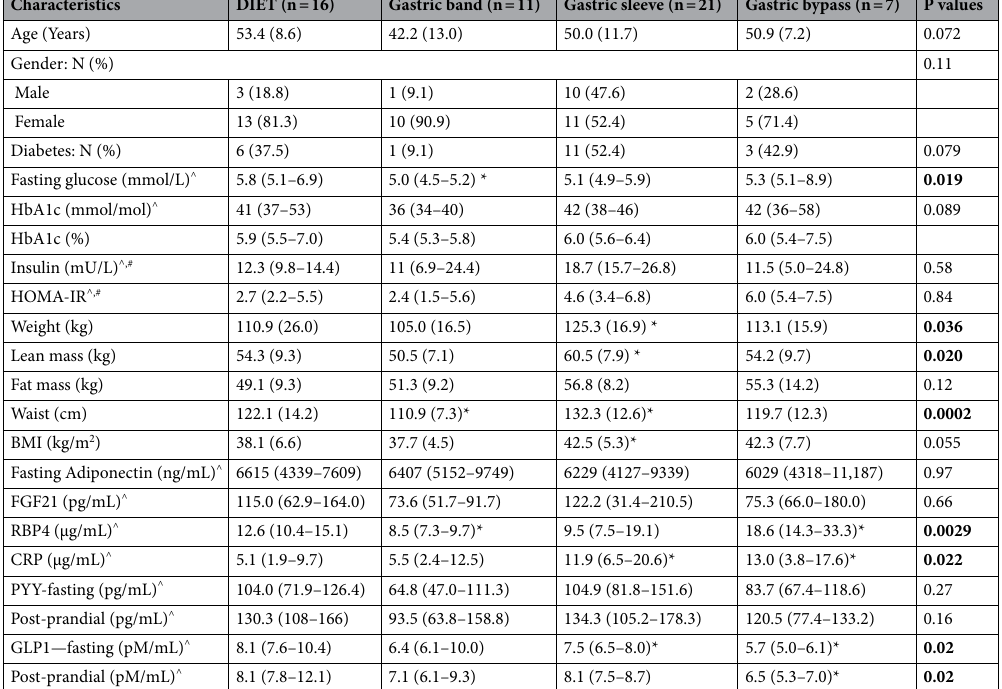
Table 1. Baseline characteristics. Baseline characteristics of participants. Data are reported as count (%) for categorical data, mean (SD) for normally distributed continuous data and ^ median (IQR) for non-normally distributed continuous data. # Includes only those participants not taking diabetes medications (diet n = 9, LAGB n = 11, GS n = 12, RYGB n = 4). *Statistically significantly different from Diet group (post-hoc test). Significant values are in bold.